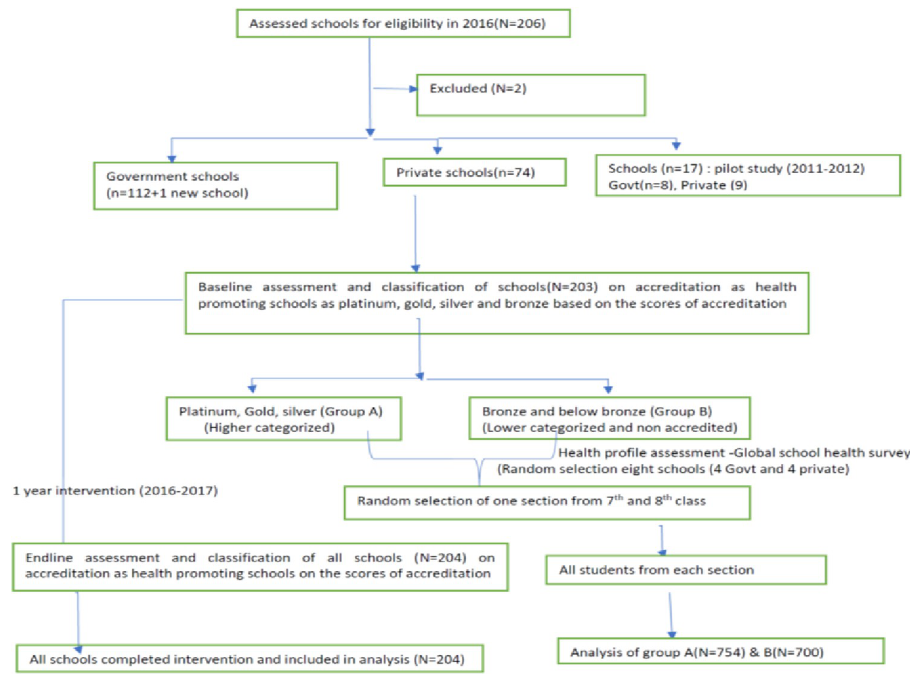
Fig 2. Participating schools flow